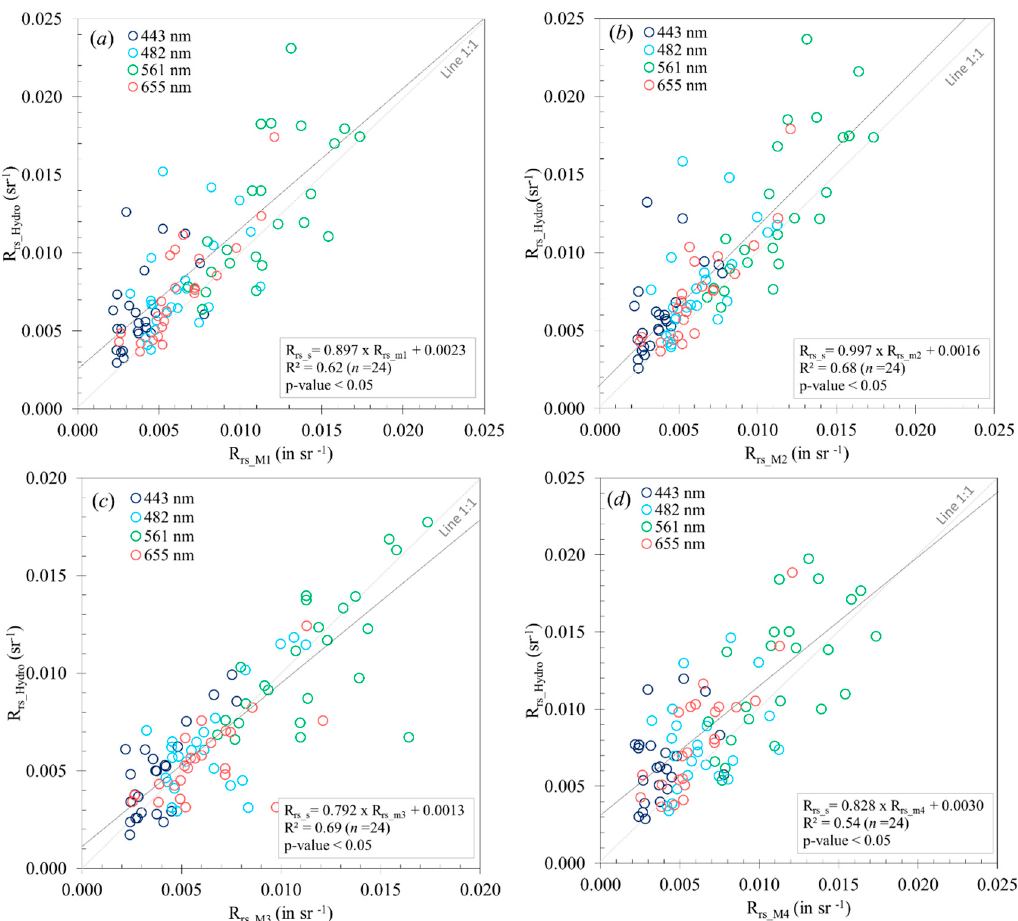
Figure 6. Plots of HydroLight simulations (R rs_Hydro ) against ( a ) M1; ( b ) M2; ( c ) M3; and ( d ) M4 glint corrected R rs . Highlight: R rs datasets (in situ and simulated, n = 24) were spectral resampled for OLI bands for comparisons. Table 5. nRMSDs (%) for in situ R rs retrieved from M1, M2, M3 and M4 methods using HydroLight R rs as reference